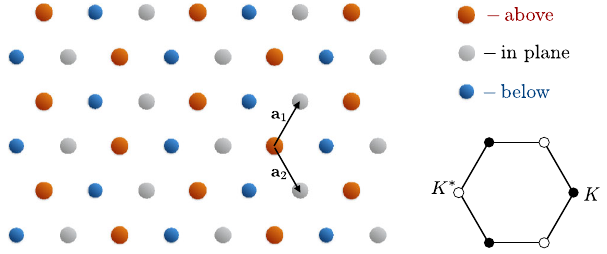
FIG. 1. Ions in a planar trap form a hexagonal lattice, which undergoes a mechanical instability as a function of the temper- ature and/or the transverse frequency. Left panel: Height pattern in the ordered phase. The hexagonal lattice is split into three sublattices, one of which stays in the z ¼ 0 plane (gray circles), one is raised above it (red), and one is lowered below it (blue). There are six inequivalent configurations, corresponding to the 3! possible height assignments to the sublattices. Right panel: The first Brillouin zone of the undistorted hexagonal lattice is shown, together with the wave vectors K and K (cid:2) ¼ − K corresponding to the height